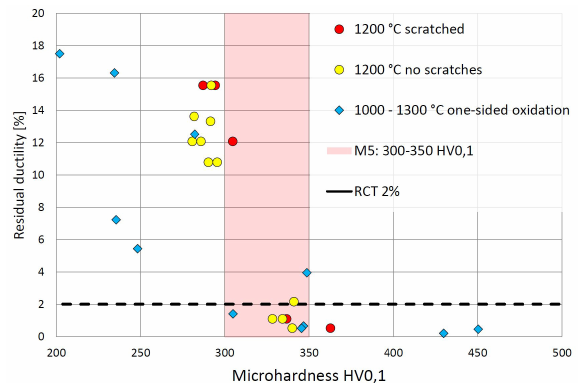
Figure 15. Comparison of obtained results with the ones presented in other